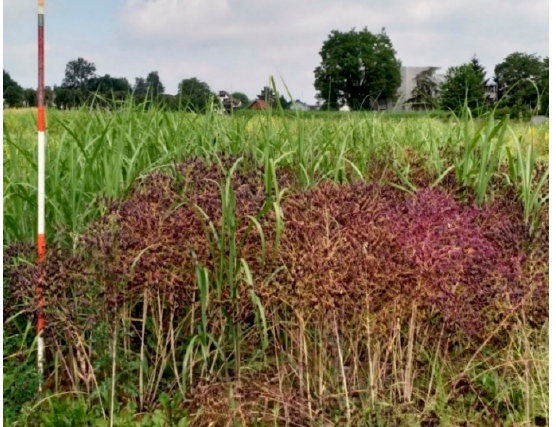
Figure 6. Plant stand of treatment woad and miscanthus (WAM) during the vegetation period in 2018. Picture taken on 8 June 2018. Table 1. Overview of yield and morphological parameters of WAM and YAM at harvest on 5 April 2018.